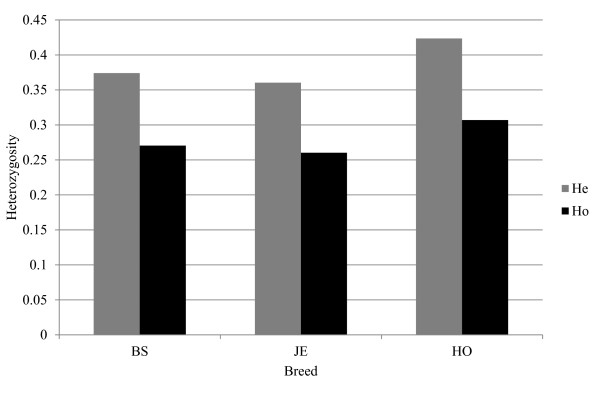
Average gene diversity expressed in terms of heterozygosity expected under random mating (He) and observed heterozygosity (Ho).